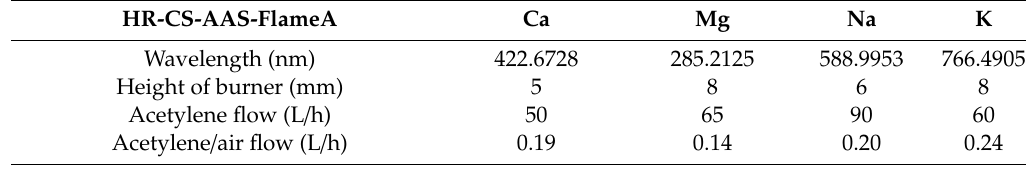
Table 3. Optimized experimental conditions used in High-Resolution Continuum Source Atomic Absorption Spectrometer (HR-CS-AAS) with atomization by flame (Ca, Mg, Na, and K) and graphite furnace (Cu, Fe, Mn, and